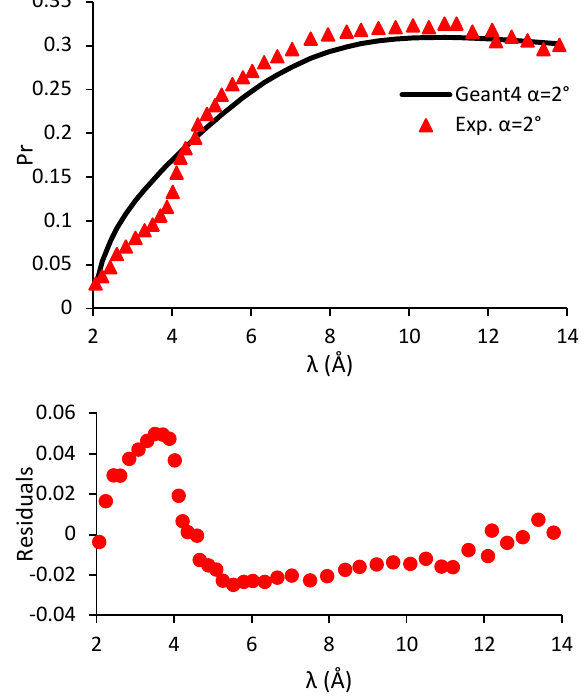
Fig. 5 . Quasi-specular reflection of CN with incident angle of